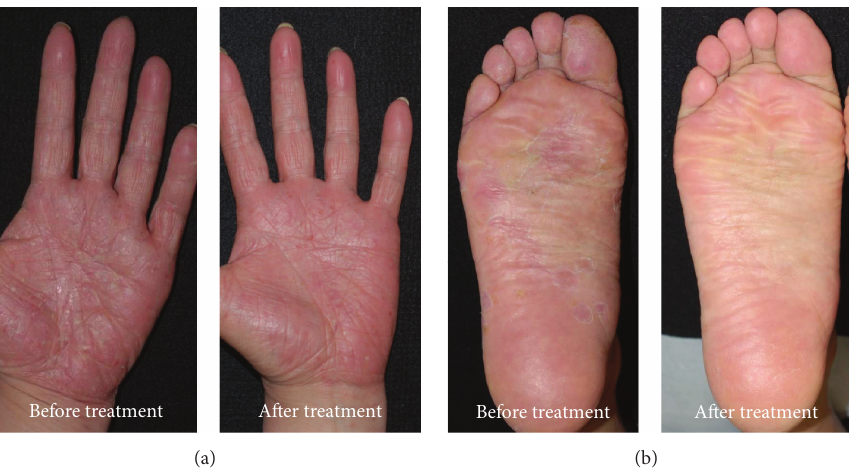
Figure 1: (a) Case 1 . Multiple pustules over the left palm with scaling and erythema were markedly improved after 6-week treatment. (b) Case 7 . Hyperkeratotic lesions over the right sole disappeared after 4-week treatment.